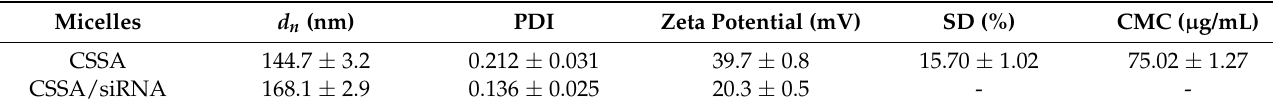
Table 1. Characteristics of CSSA and CSSA/siRNA micelles.